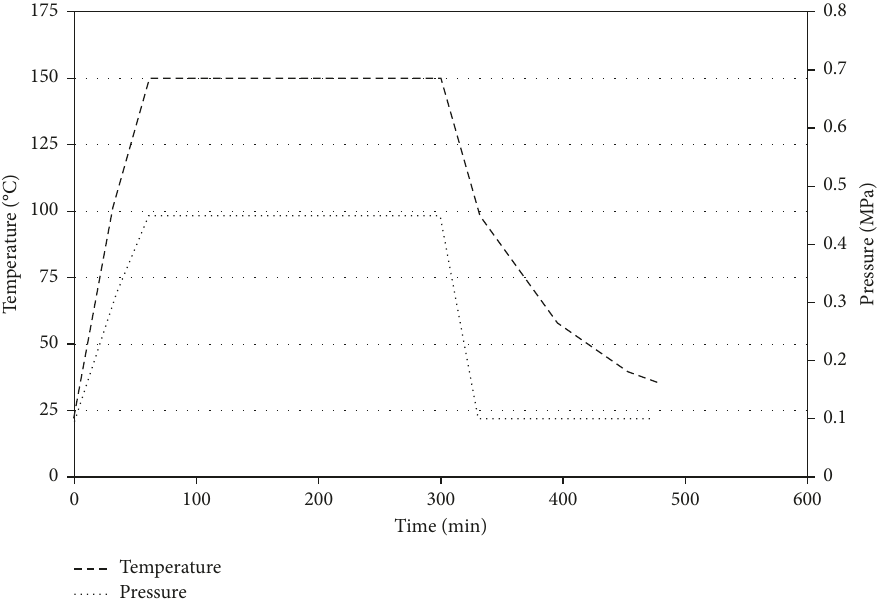
Figure 4: Illustration of applied hydrothermal